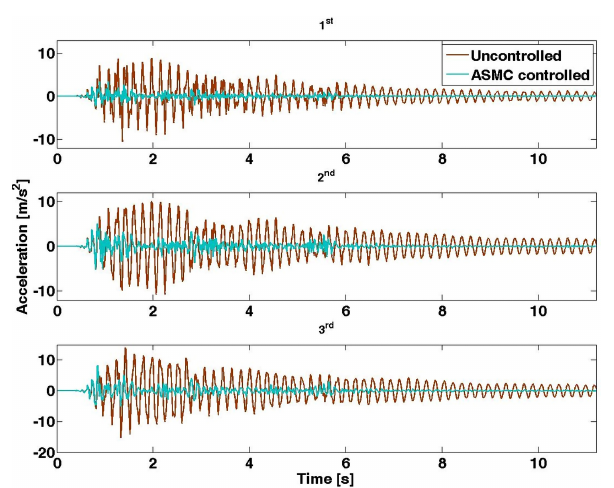
Figure 10. Structure floor acceleration responses to the 1940 El Centro earthquake.